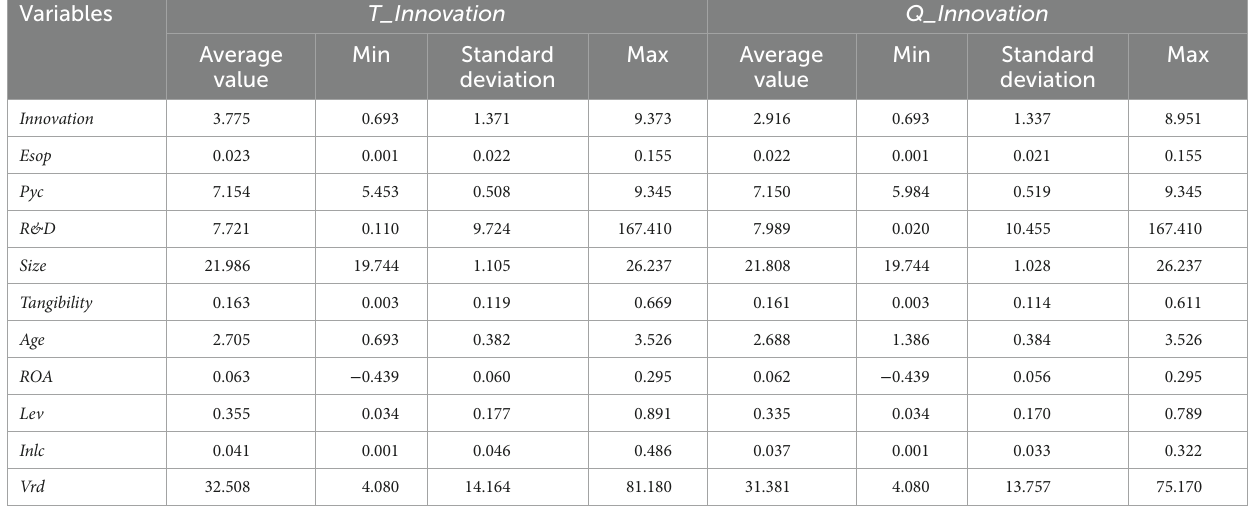
TABLE 3 Descriptive statistics of variables.